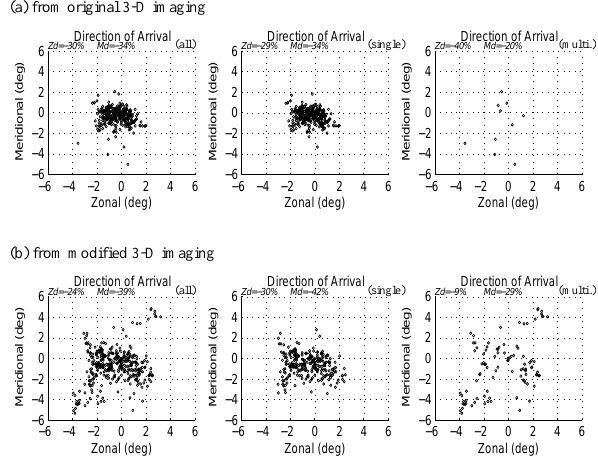
Figure 6. Angular locations of echo centers at range locations of -120m, -90m, -60m, -30m, 0m, 30m, 60m, 90m, and 120m in the sampling gate centered at 5.325 km. (a) and (b) result from the 3-D radar imaging of the wavy layer structure with and without correction of spatial weighting effect, respectively. The left-hand plots show all estimates, and the middle and right-hand plots display the situations of single center and multiple centers, respectively.